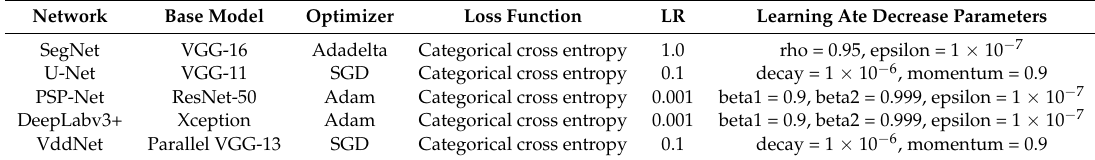
Table 2. The parameters used for the different deep learning architectures. LR means learning rate.